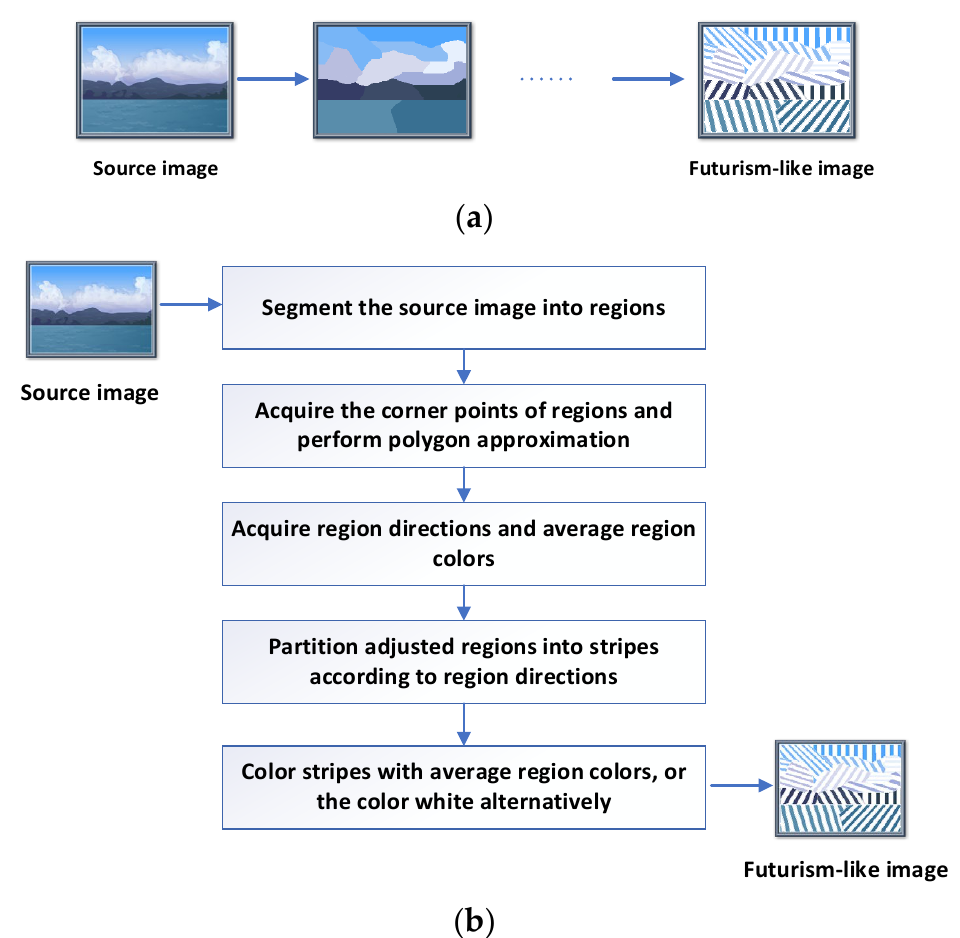
Figure 5. An illustration of the proposed method for stripe-based Futurism-like art image creation. ( a ) Basic idea. ( b ) A flowchart of the image creation process.